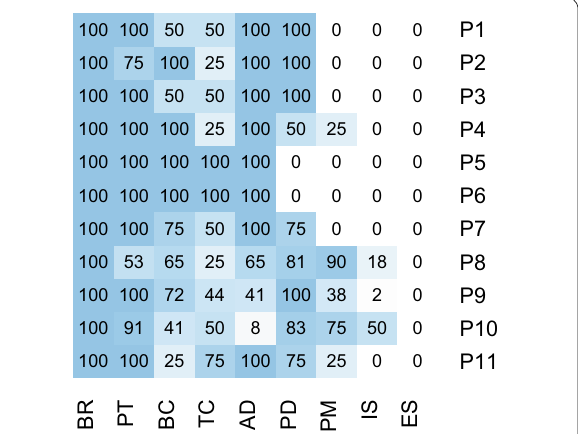
Fig. 6 Probability of each patient’s muscles being used to represent a task according to the muscle selection method [42]